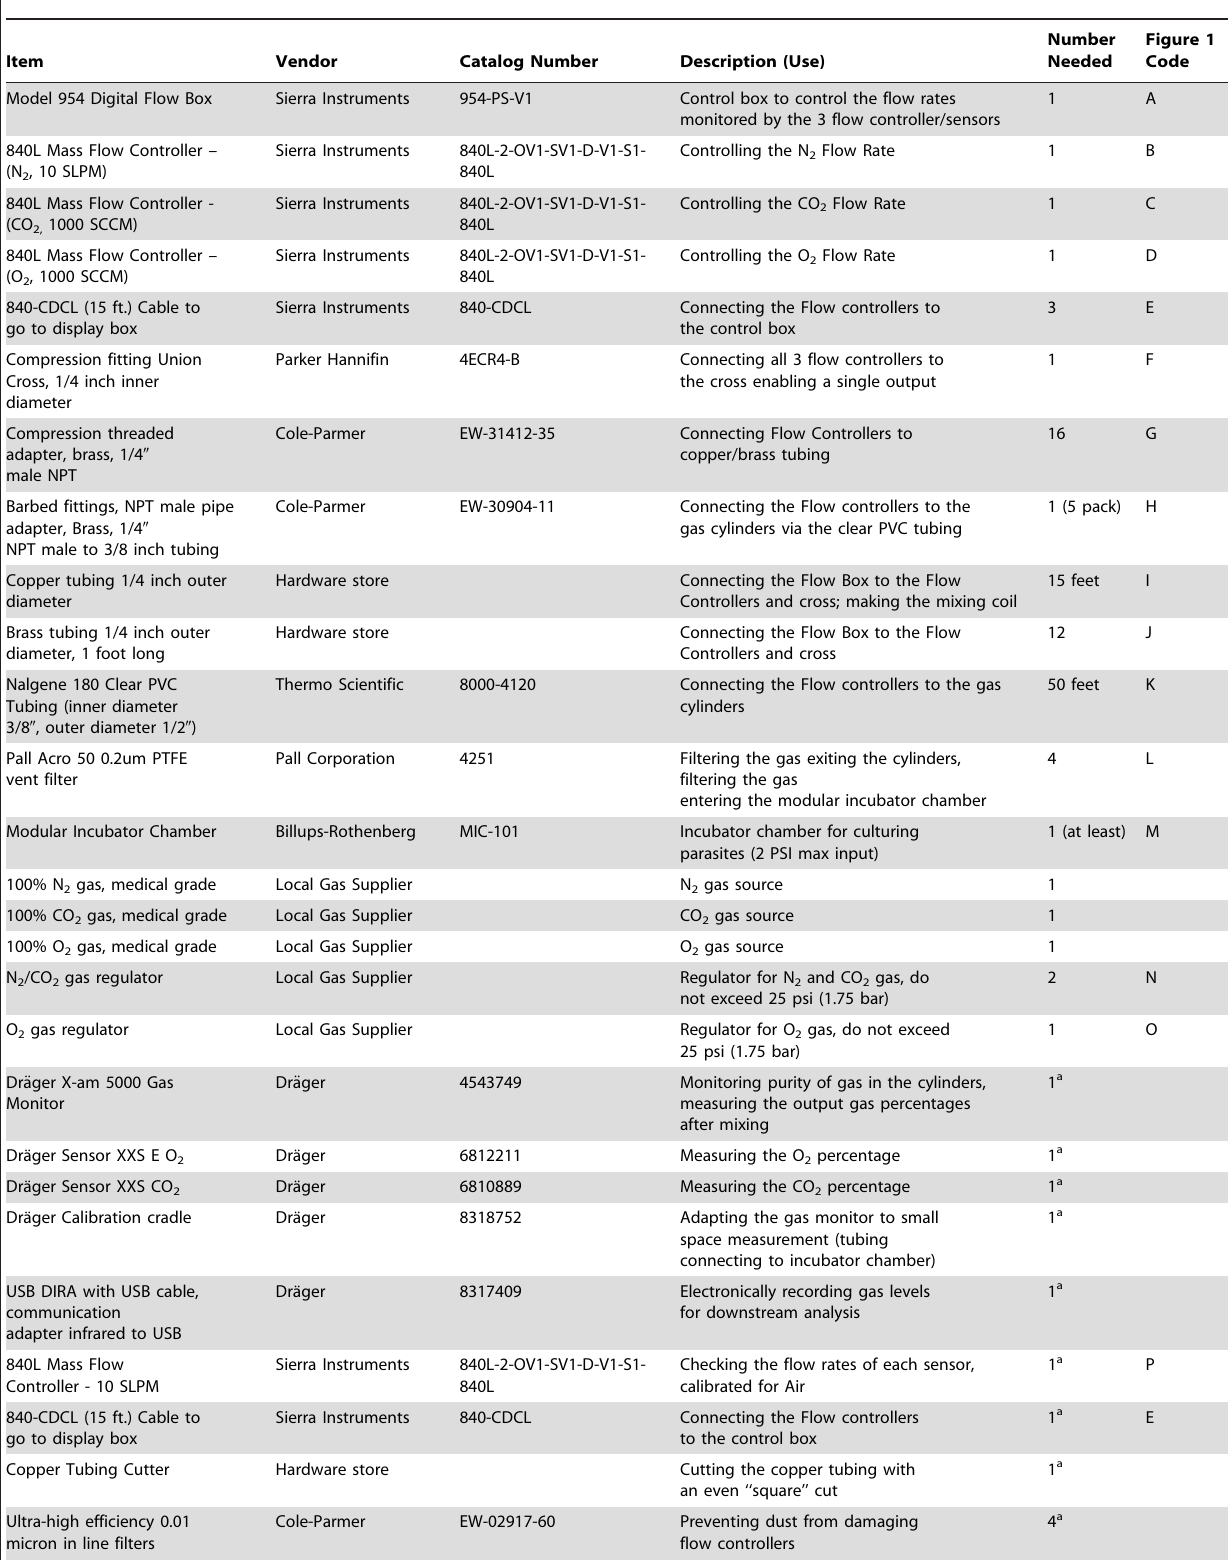
Table 1. Necessary supplies and useful accessories for assembling an adjustable gas